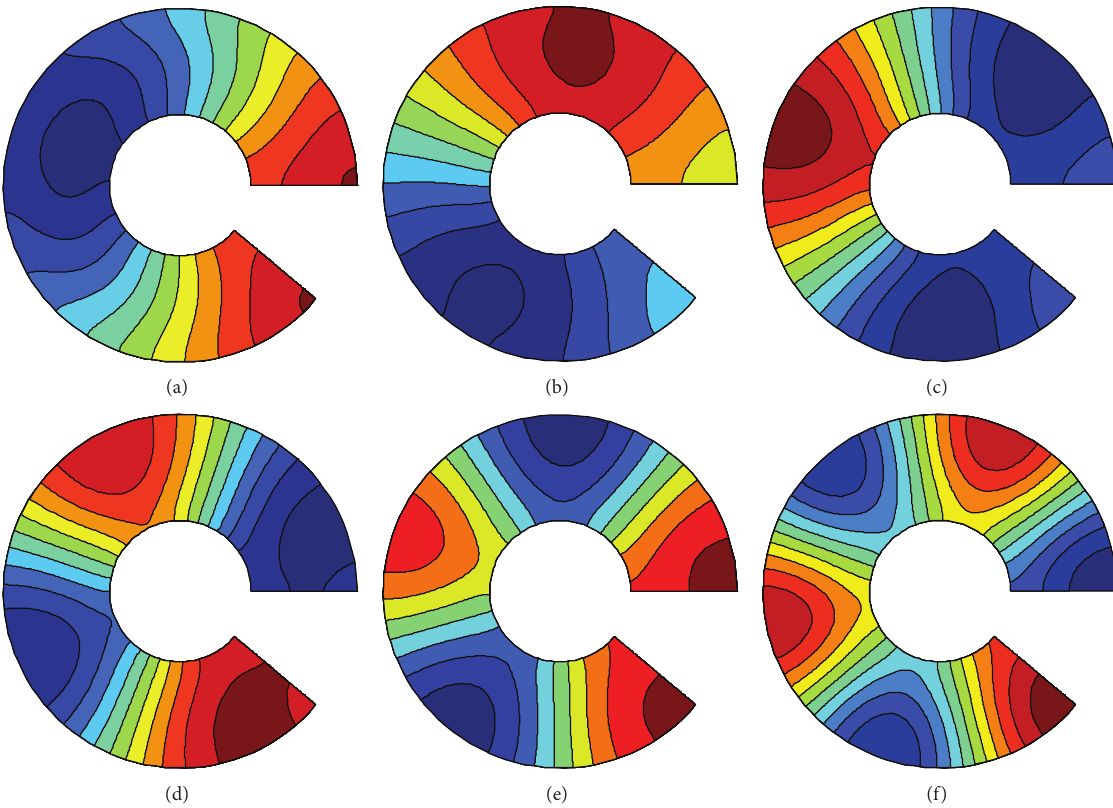
Figure 3: The first six mode shapes for an annular sector plate (𝑎/𝑏 = 0.4 and 𝜙 = 16𝜋/9) with elastic restraints, 𝑘 = 10 5 N/m and 𝐾 = 10 7 Nm/rad, at all the four edges: the (a) first, (b) second, (c) third, (d) fourth, (e) fifth, and (f) sixth mode shape.